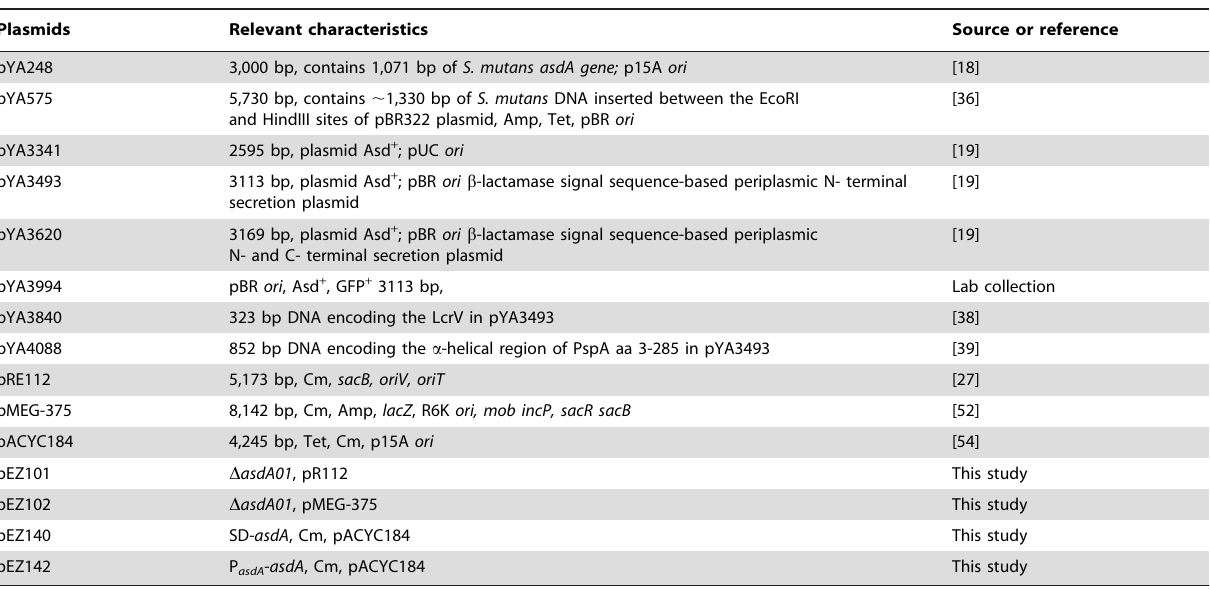
Table 2. Plasmid used in this study.